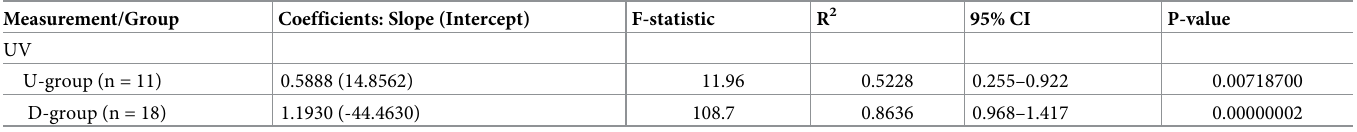
Table 4. A correlation on glucose levels between the anterior chamber and blood in Study 1 and 2 subjects.